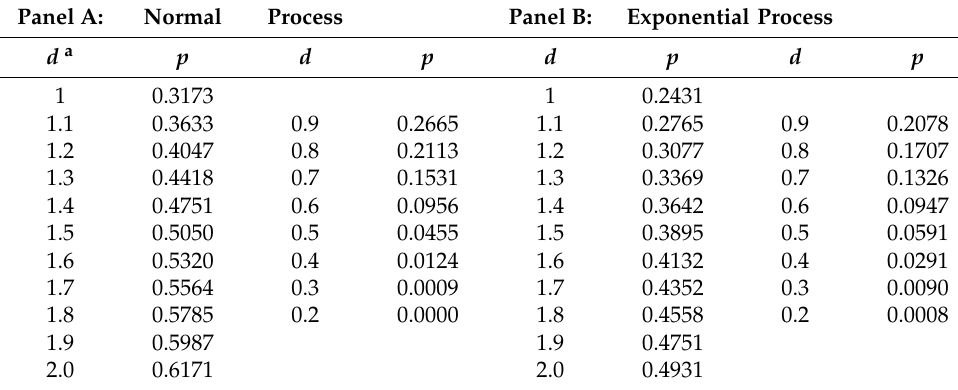
Table 6. The relationship between the shift factor d and